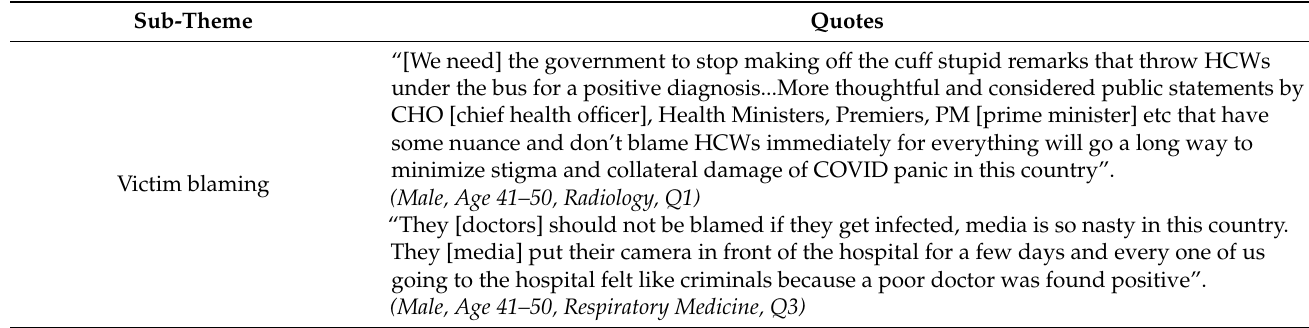
Table 5. Poor political leadership, planning, and